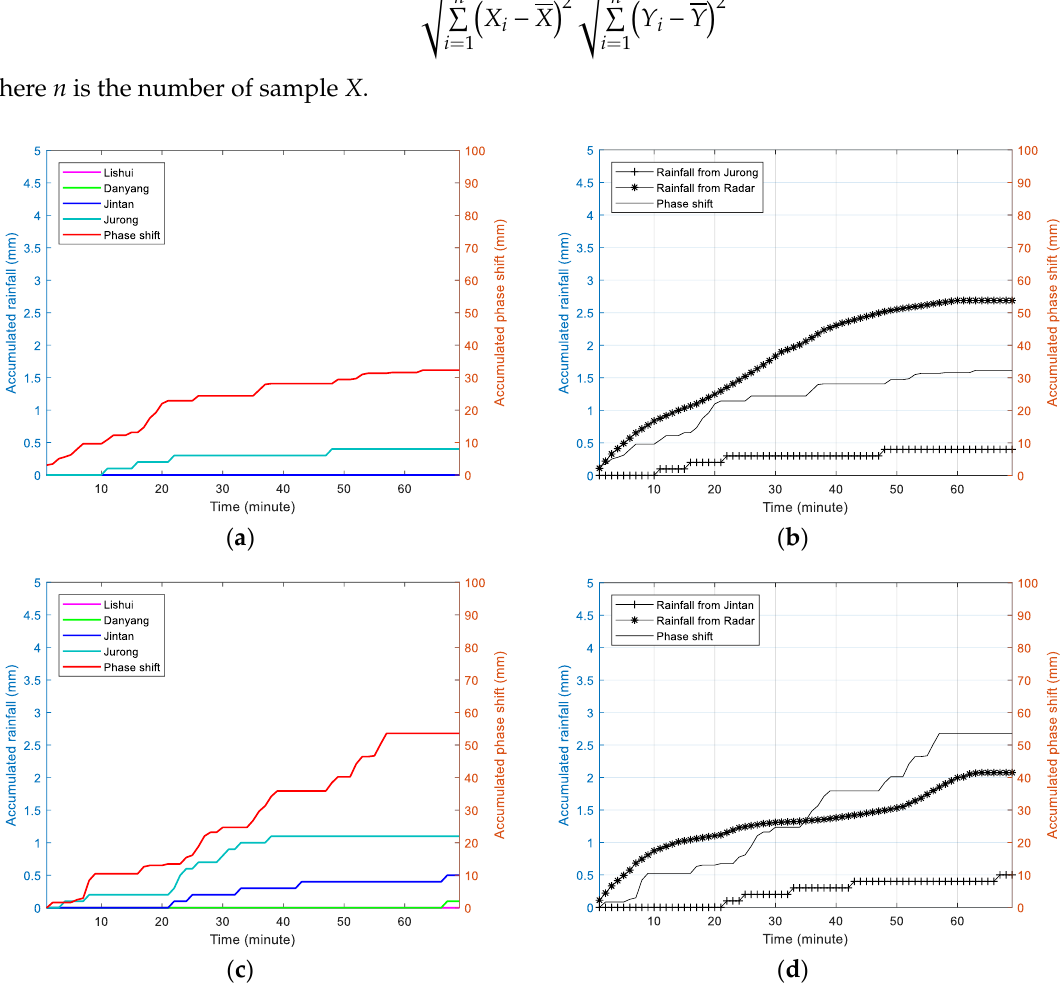
Figure 8. Cases of accumulated phase shift compared with accumulated rainfall observed from four weather stations and calculated from radar, respectively: ( a , b ) on 6 July 2015; ( c , d ) on 10 August 2015. It is obvious that the rain gauges variation of rain is only temporal, but for the phase the location